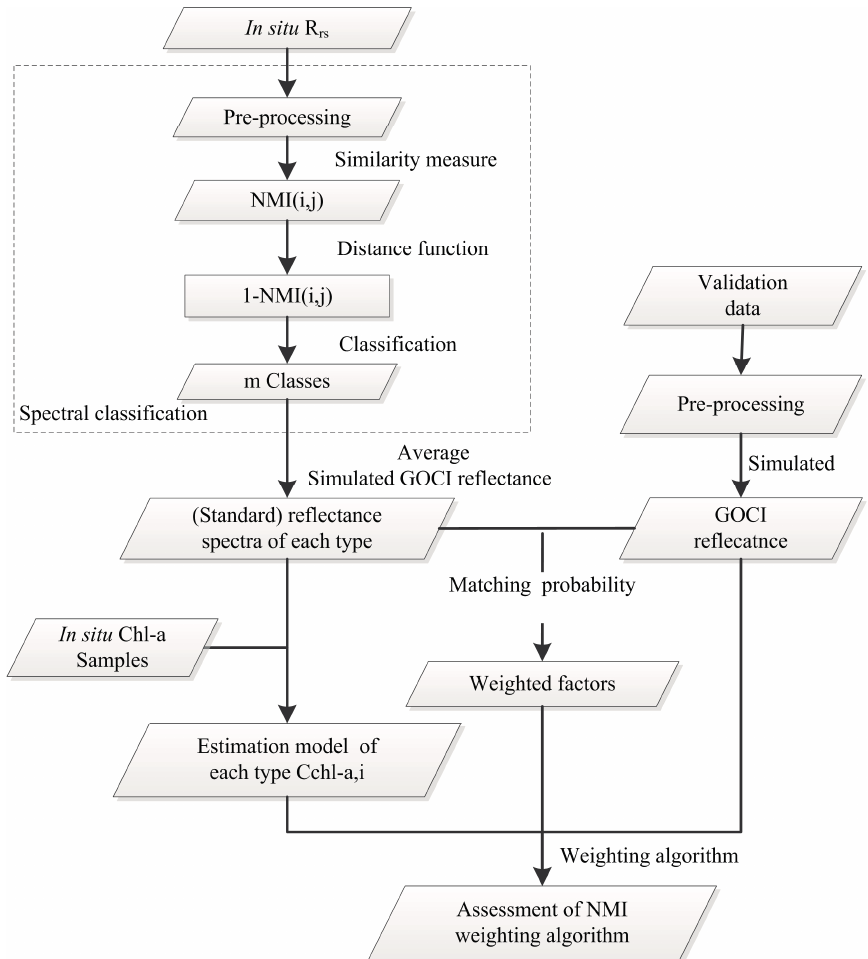
Figure 1. Flowchart of the estimation of Chl-a based on the NMI classification and the weighted